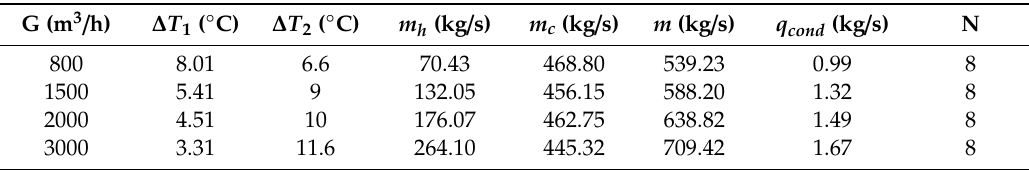
Table 3. Operation parameters with different G values.